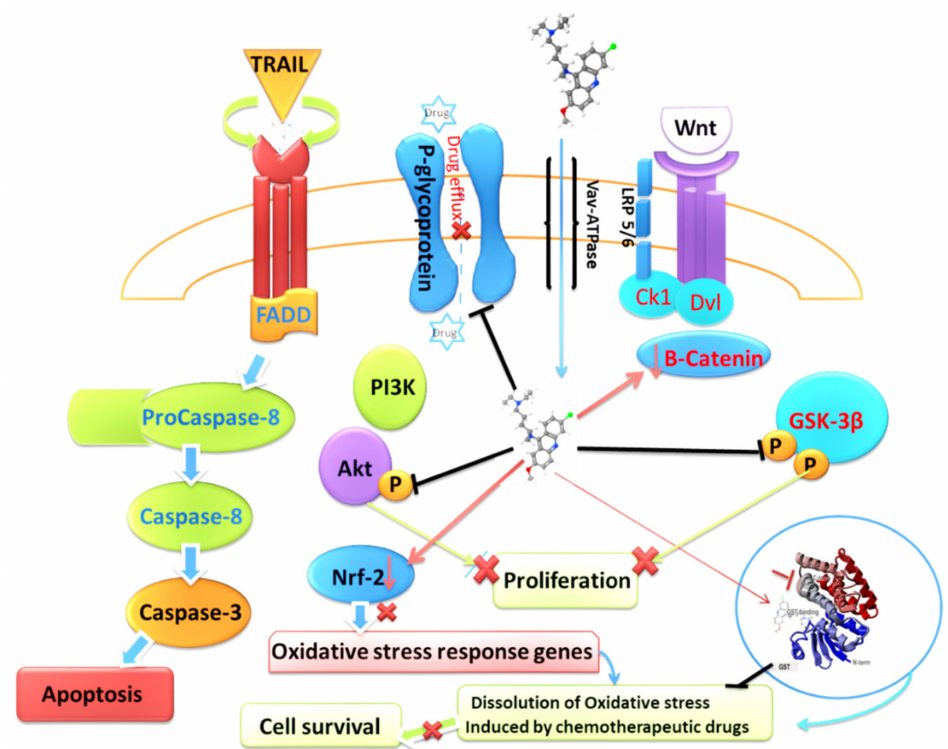
Figure 2. Graphic describing the effect of QC on chemoresistance pathways enacted and utilized by cancer